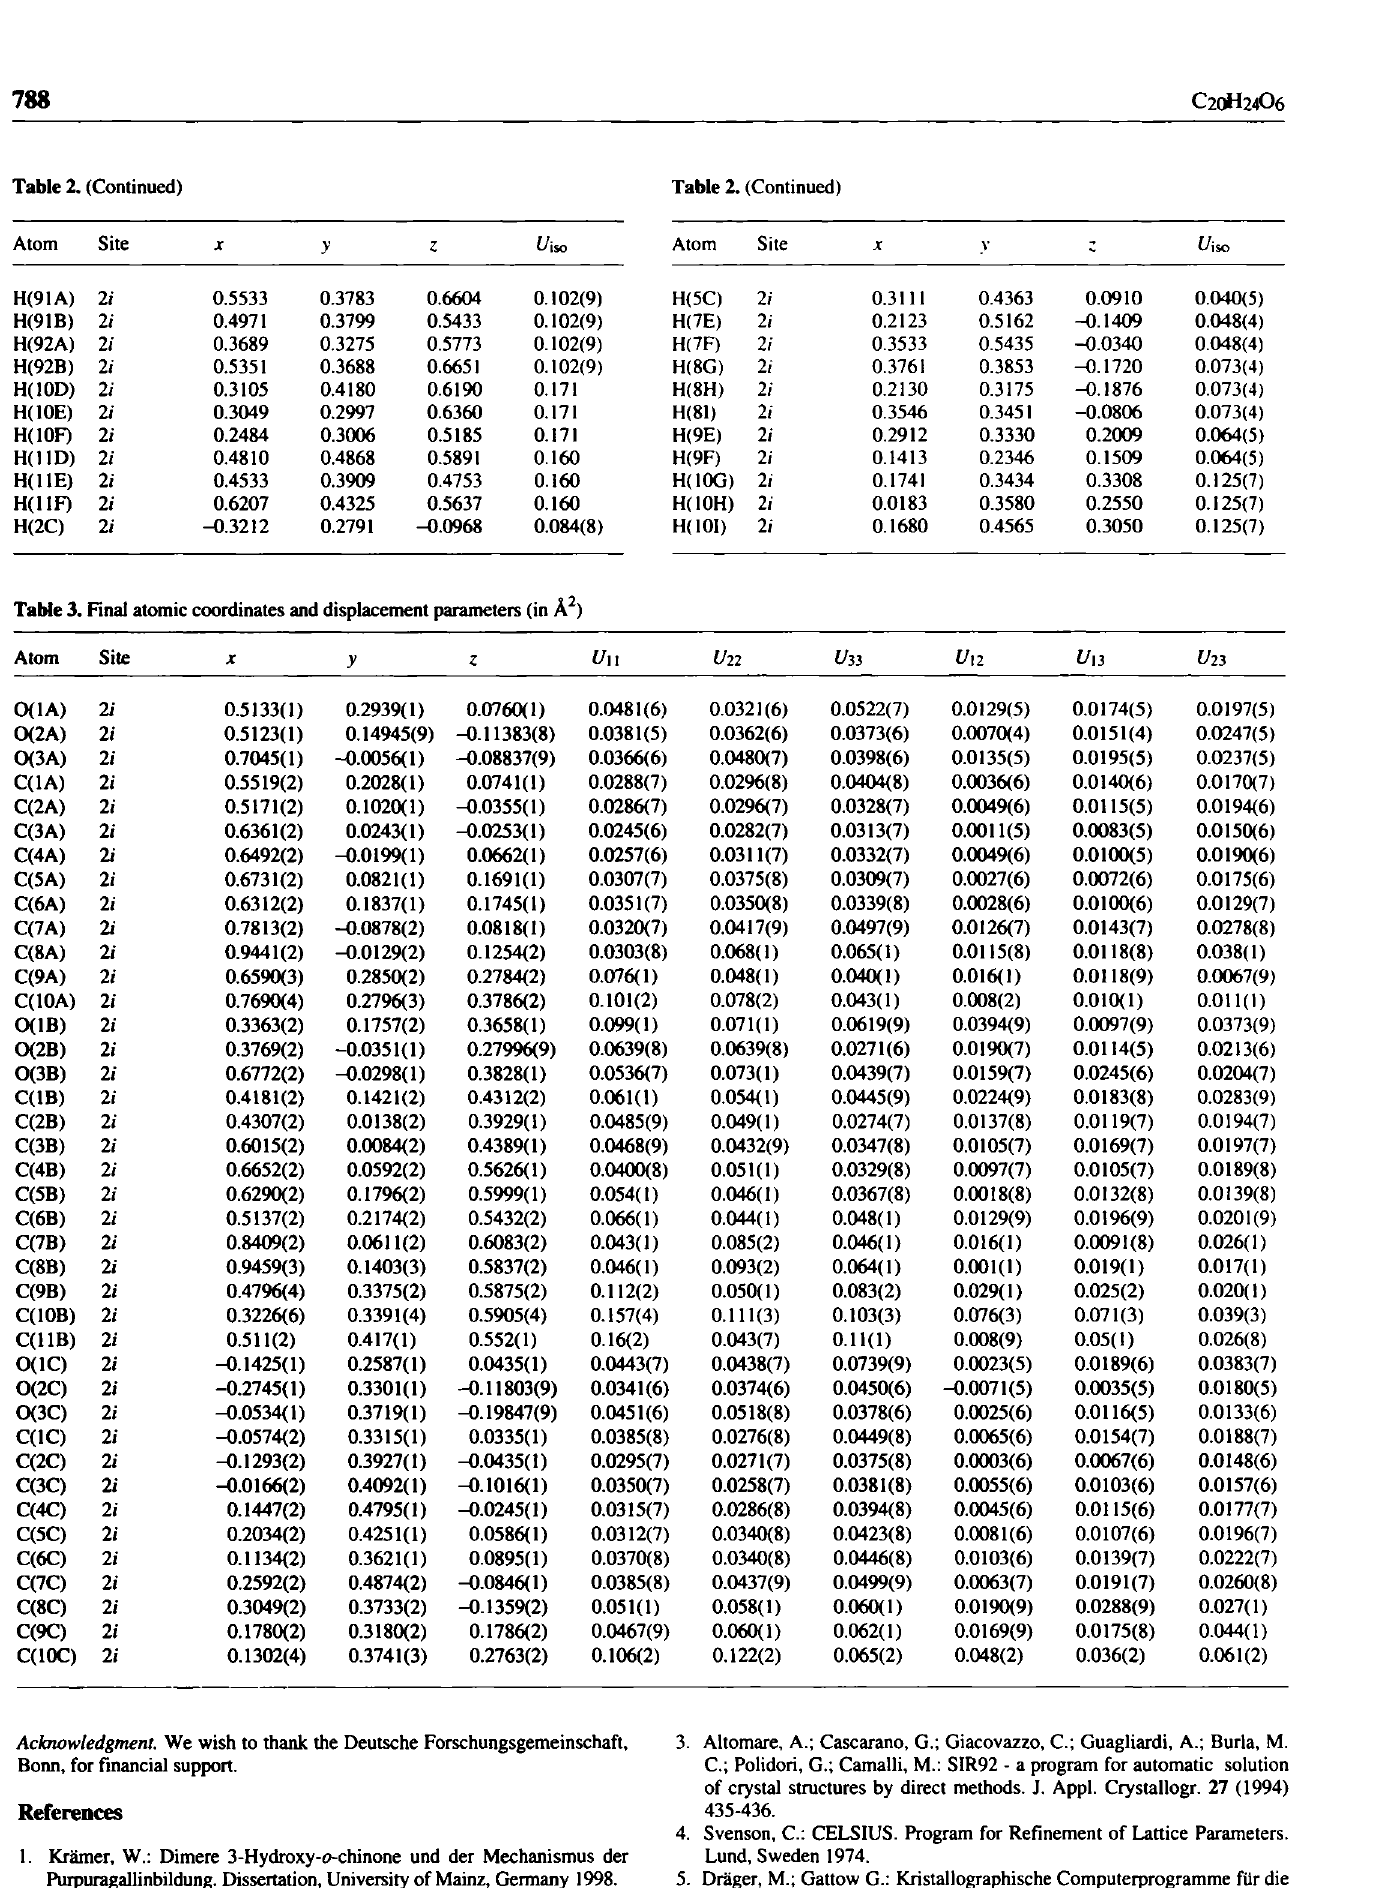
Table 3. Final atomic coordinates and displacement parameters (in